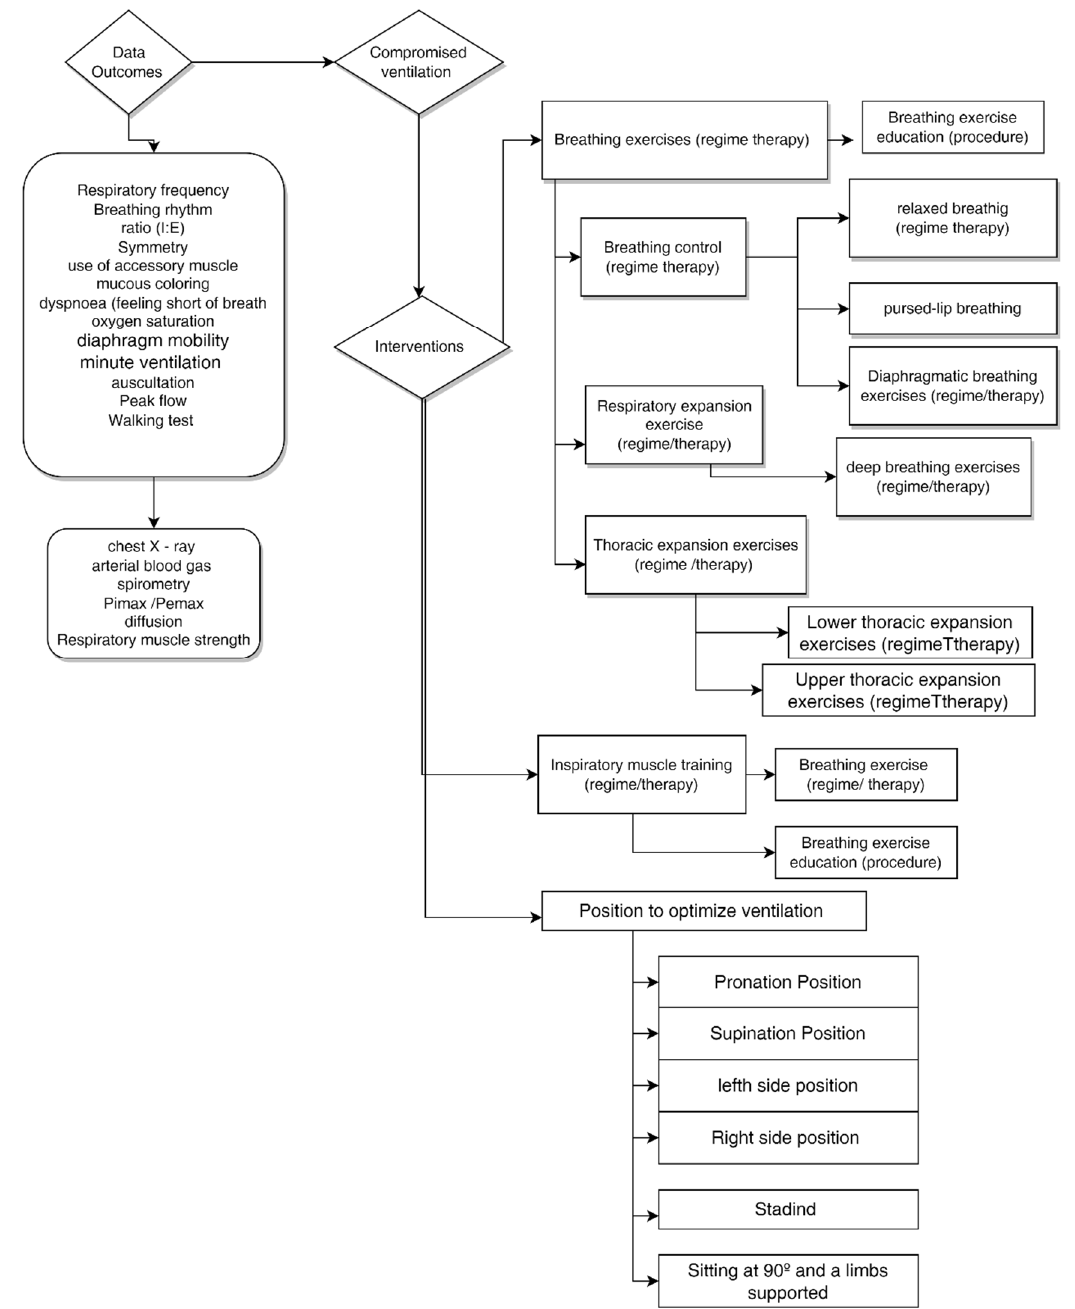
Figure 2. Mapping of interventions and their relationship with data/outcomes.